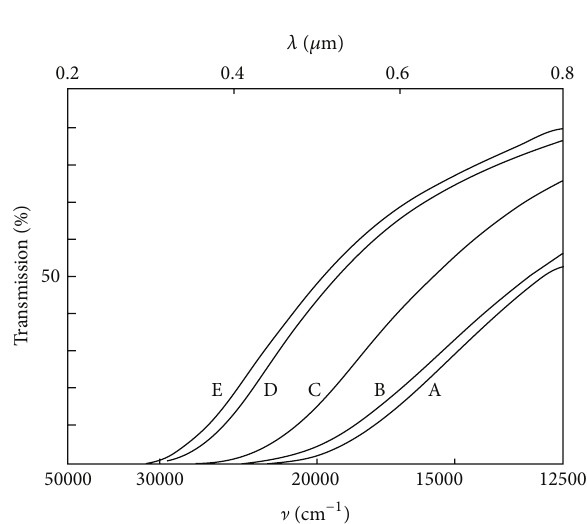
Figure 4: UV-visible transmission of aerogels with different TEOS